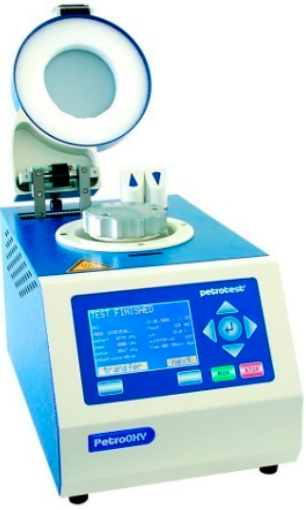
Figure 5. RapidOxy ® apparatus for measurement of oxygen consumption during the autoxidation